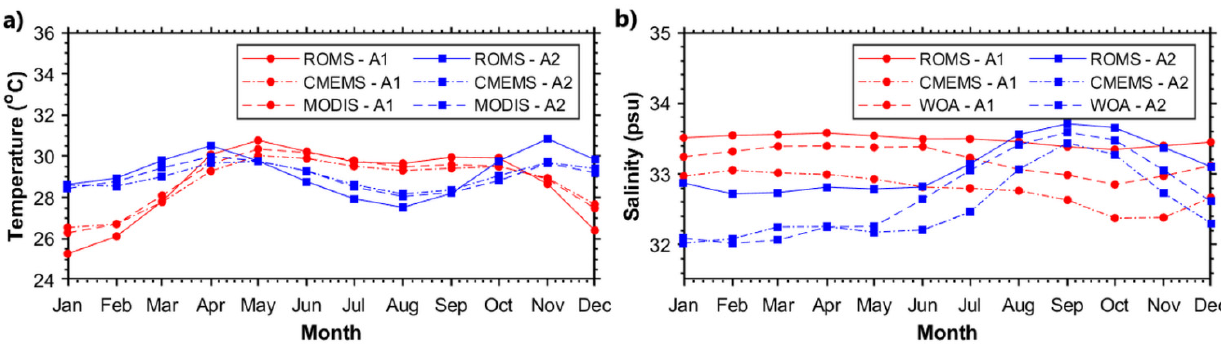
Figure 7. Seasonal cycle of ( a ) SST (unit: °C) and ( b ) SSS (unit: psu) climatology derived from ROMS (solid lines), CMEMS (dash-dot lines), and MODIS/WOA (dashed lines) for Region A1 (red circles) and A2 (blue squares).